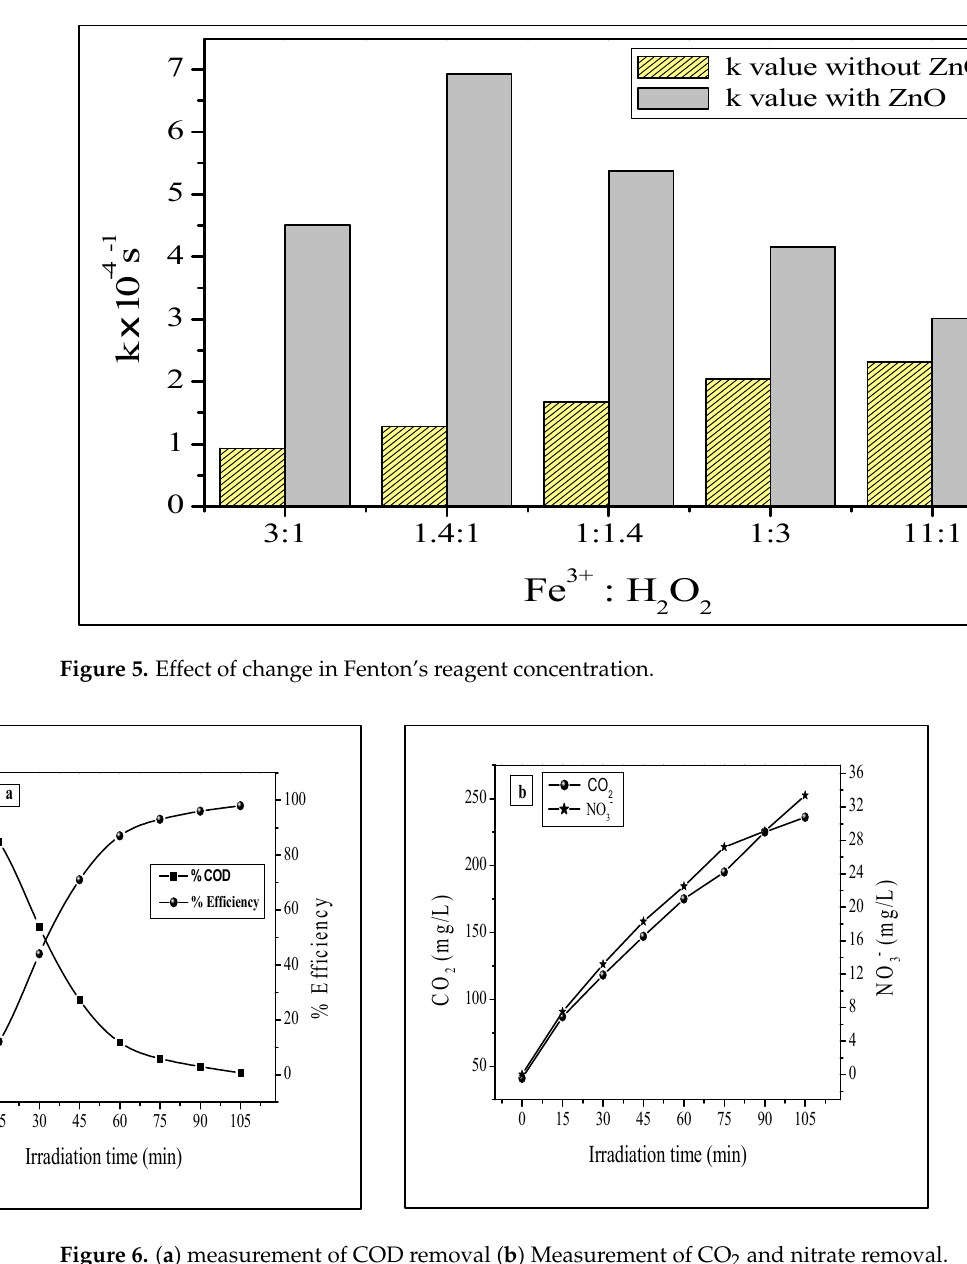
Figure 7. Effect of bubbling of N 2 and O 2 purging.